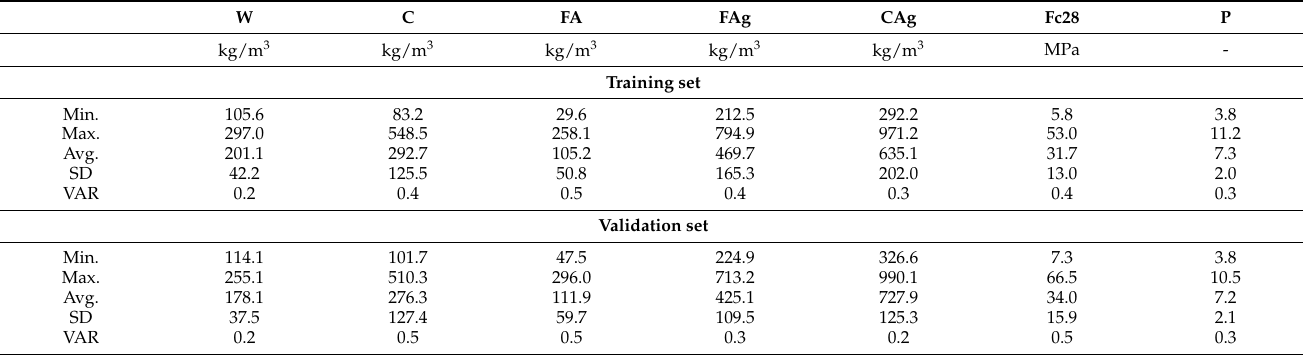
Table 2. Statistical analysis of collected FA–concrete